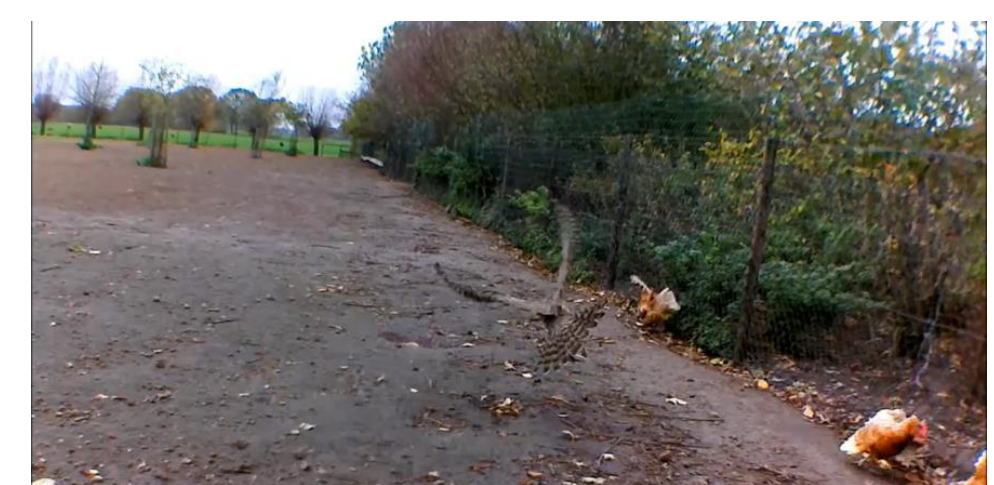
Figure 2. Hens on farm 8 performed normal foraging behaviour (‘walking with pecking and scratching’ [11]) while being watched by 2 common buzzards ( Buteo buteo ).